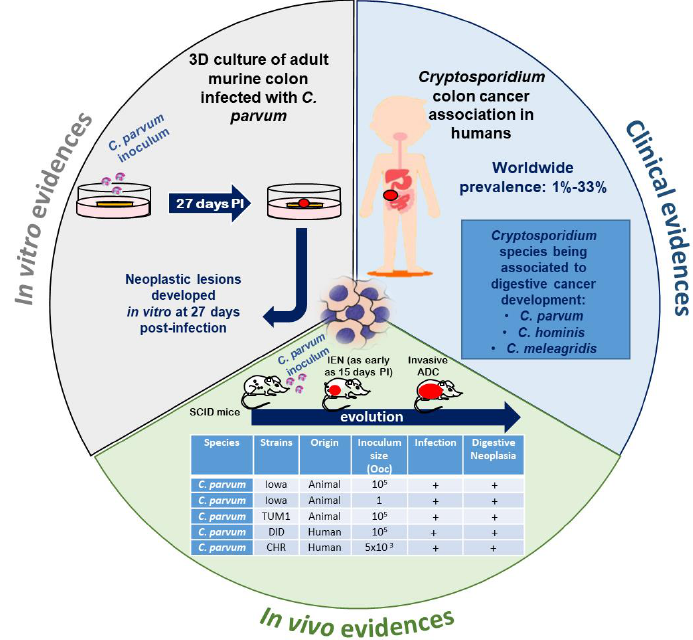
Figure 2. Recent experimental and clinical approaches contributing to expanding the understanding of the role of Cryptosporidium in the induction of digestive neoplasia. PI: post-infection, IEN: intraepithelial neoplasia, ADC: adenocarcinoma, Ooc: oocysts. Source of pictograms: https://fr.freepik.com/photos-vecteurs-libre/banner”>Banner